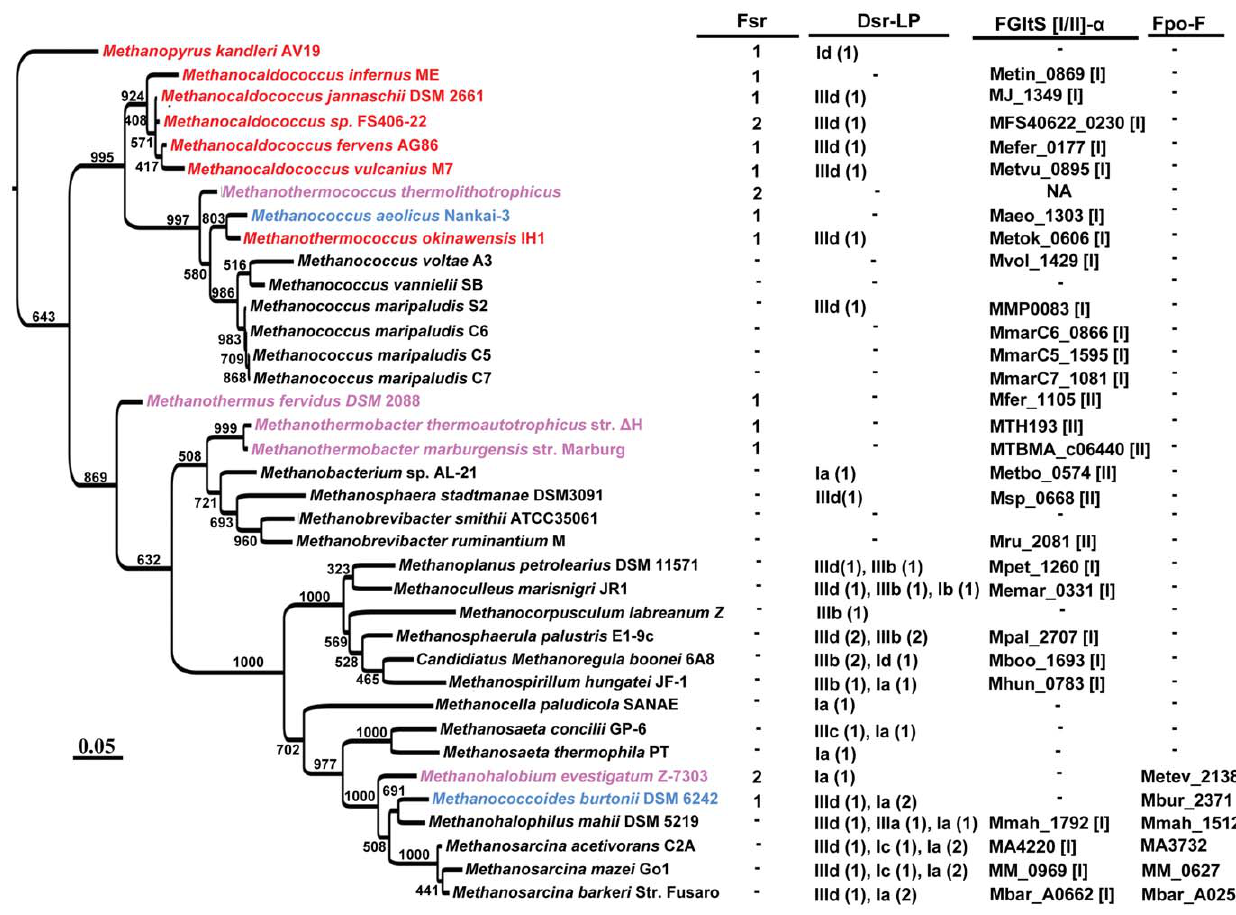
Figure 2. Distribution of Dsr-LP, Fsr, FGltS(I/II)- a and FpoF in methanogenic archaea. The information has been presented on a 16S rRNA sequence based phylogenetic tree of methanogens for which whole genome sequences are available. Desulfurococcus fermentans was used as an outgroup. The confidence values presented at the branches of the tree were estimated from 1000 bootstrap repetitions; the scale bar underneath the tree indicates the number of base substitutions per site. (1 or 2), number of each type of sulfite reductase homolog in a methanogen. Dsr-LP: dissimilatory sulfite reductase-like proteins; Fsr, FGltS(I/II)- a , and FpoF: same as in the legend of Fig. 1. The Dsr-LP group numbers (Ia-d and IIIa-d) are according to Fig. 3. Color representation of Fsr-containing methanogens (color, characteristic); red, hyperthermophilic vent methanogen (except M. okinawensis is a thermophile); lavender, thermophile; blue, mesophile and psycrophile. Classification of FGltS according to Fig. 6 is shown in square brackets. (Figs. 3 and S1). The members of each group carried either three or all of the four Arg/Lys residues that define sulfite-binding sites in Dsr [21,22,23,37] and based on the positions of the missing Arg/Lys residue (1 st –4 th , counting from the NH 2 -terminus of the polypeptide; Figs. 3 and S1) they were further classified in four sub-groups. Sub-groups a, b, and c lacked the 1 st , 2 nd , and 3 rd sulfite-binding Arg/Lys residue, respectively, and d, carried all four residues (Fig. 3). The 4 th sulfite-binding residue was fully conserved across all types of sulfite reductases and therefore could be critical to the binding of an anionic substrate, sulfite or nitrite.